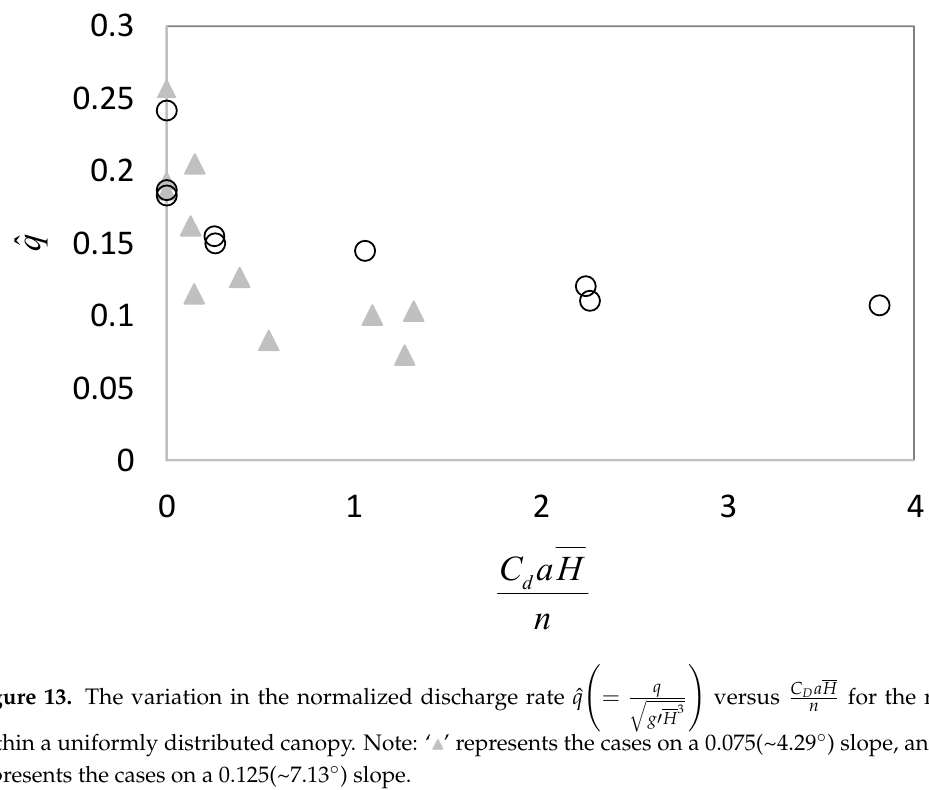
Figure 13. The variation in the normalized discharge rate (cid:1869)(cid:3548) (cid:4684)= (cid:3044) within a uniformly distributed canopy. Note: ‘ ’ represents the cases on a 0.075(~4.29°) slope, and ‘ ’ represents the cases on a 0.125(~7.13°) slope.